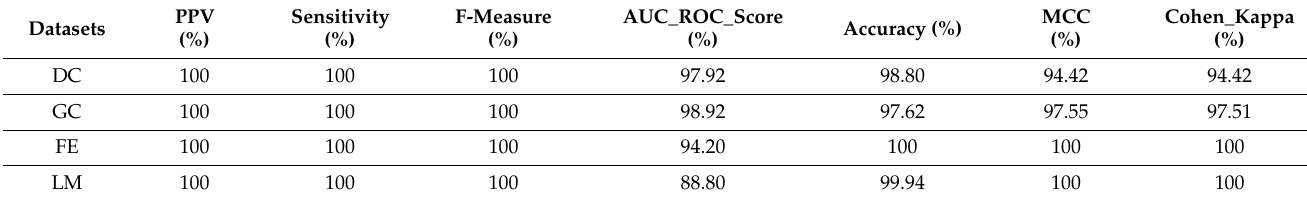
Table 6. Results of Bagging algorithm.